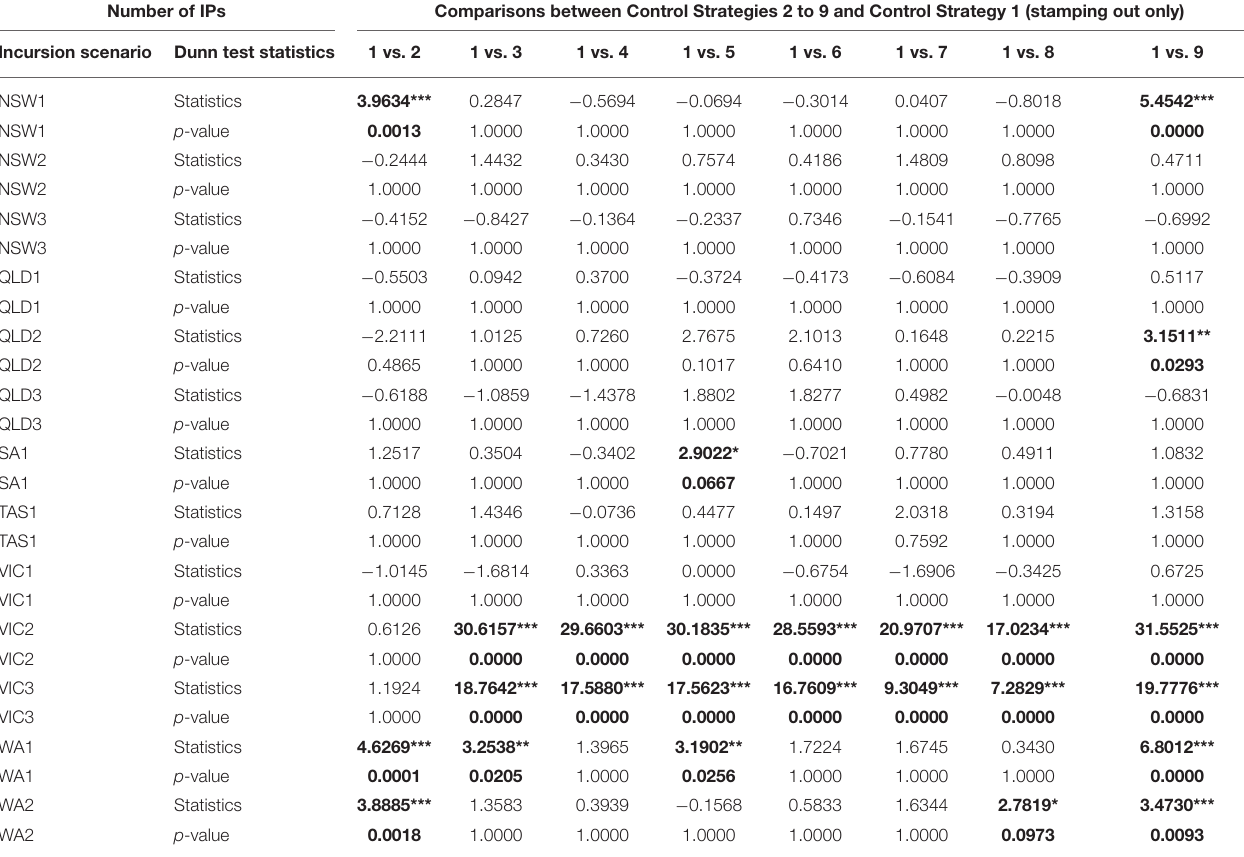
TABLE 6 | Dunn tests on number of IPs. Number of